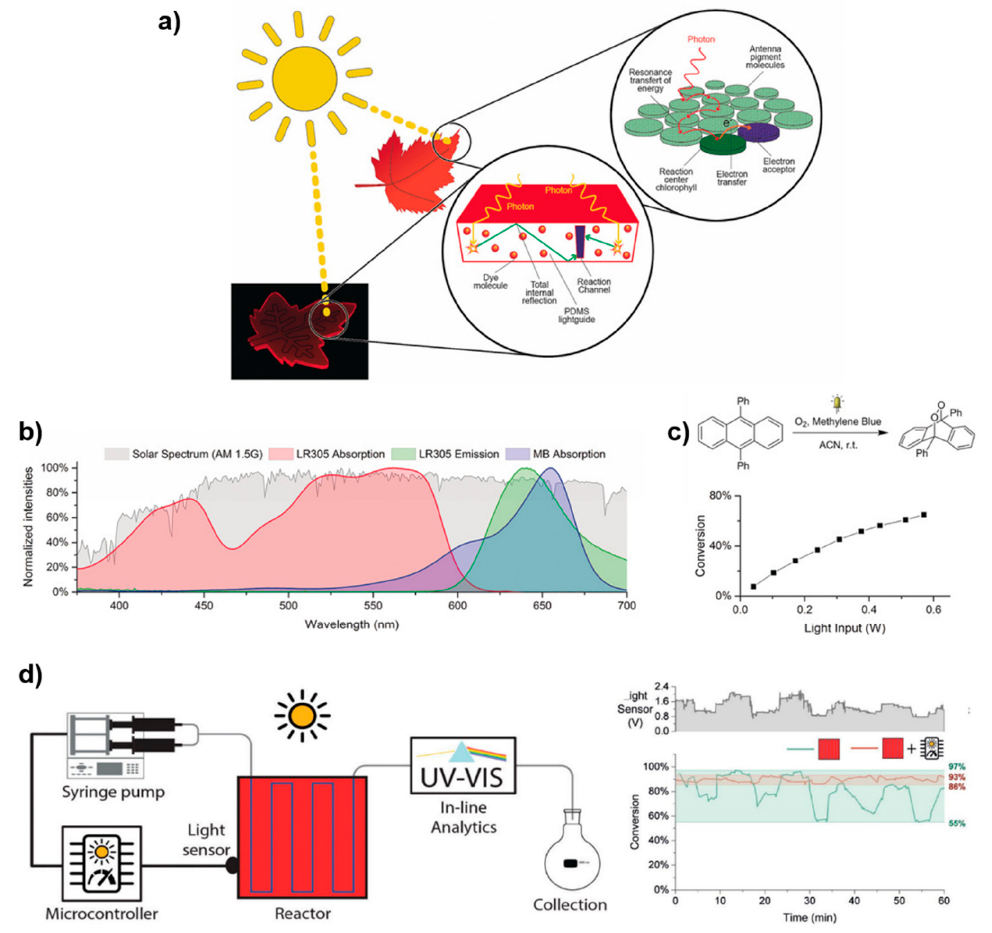
Figure 3. ( a ) Working principle of the luminescent solar concentrator photo-microreactor. ( b ) Absorption and emission spectra of LM305 compared to the absorption of MB. It is possible to observe the excellent spectral overlap between the two dyes. ( c ) The singlet oxygen-mediated cycloaddition of DPA is used as a model reaction. Reprinted with permission from Ref. [32]. Copyright 2017 John Wiley & Sons. ( d ) Improved design of the LSC-PM able to handle light fluctuations caused by passing clouds thanks to a feedback loop. Reprinted with permission from Ref. [34]. Copyright 2018 Royal Society of Chemistry.